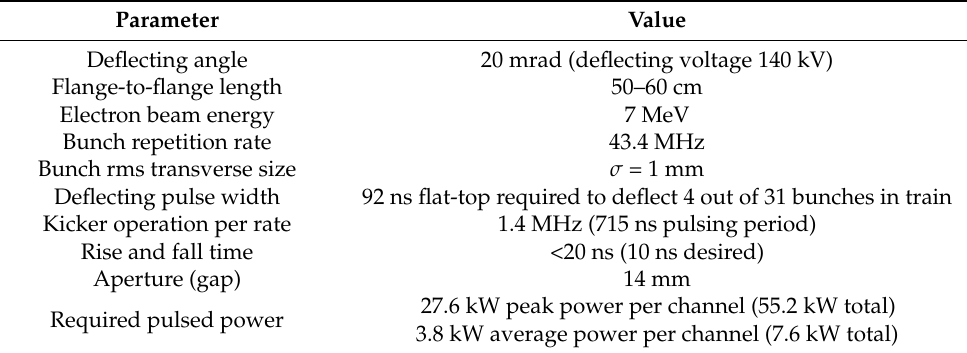
Figure 1. Kicker operation time diagram. Table 1. Design parameters of a high-voltage kicker. Table 1. Design parameters of a high-voltage